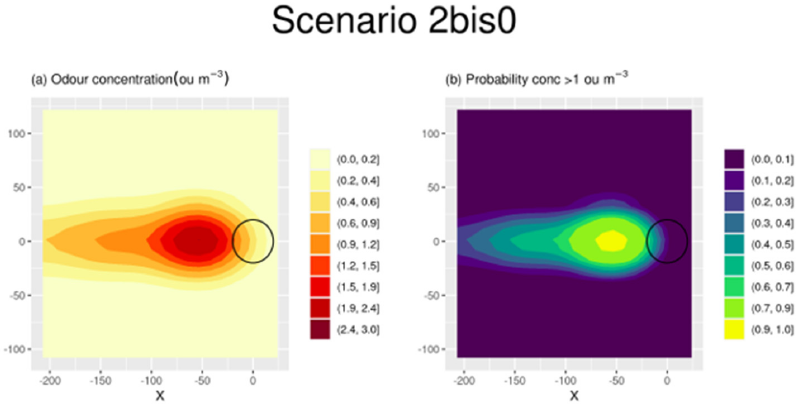
Figure 11. Odour concentrations ( a ) and exceedance probability of the 1 ou m − 3 threshold ( b ) at a 1.7 m height as simulated by SCICHEM. Meteorology and total emissions are the same as in the wind gust episode of scenario 2, but with the emission field replaced by a 40 m − diameter circular source, represented in black in the graphs. Coordinates x and y are expressed as the distances in meters from the center of the source.